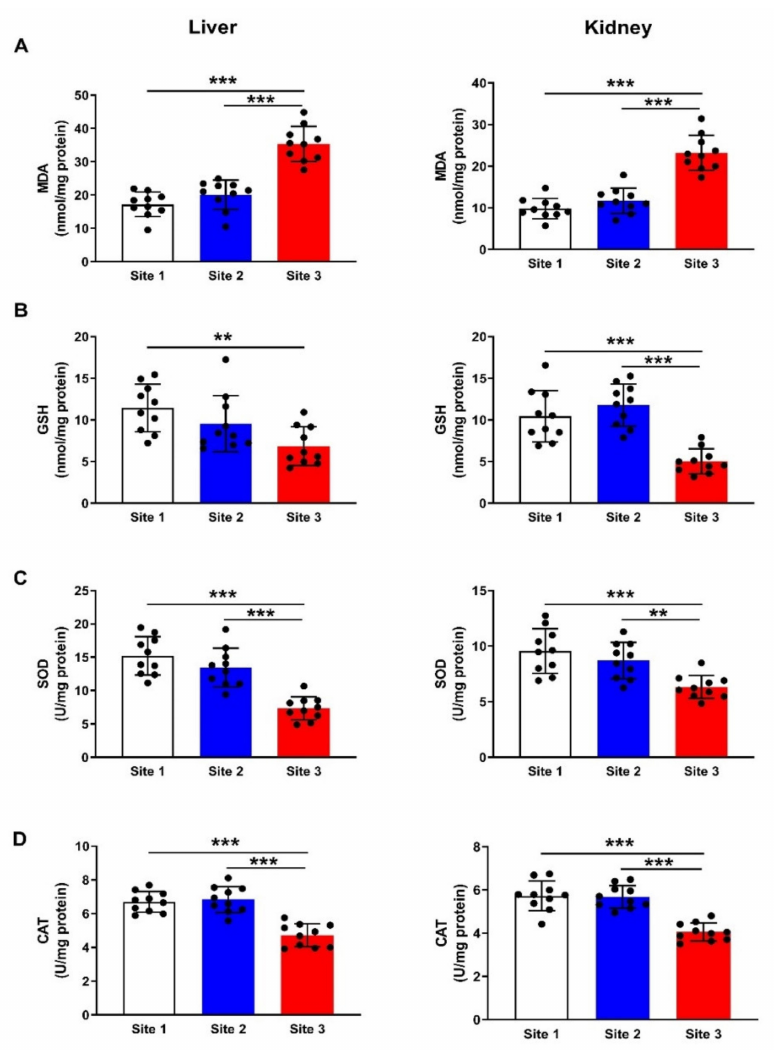
Figure 8. Levels of MDA ( A ) and GSH ( B ), and activities of SOD ( C ) and catalase ( D ) in the liver and kidneys of camels at the studied sites. Data are mean ± SD ( n = 10). ** p < 0.01 and *** p <